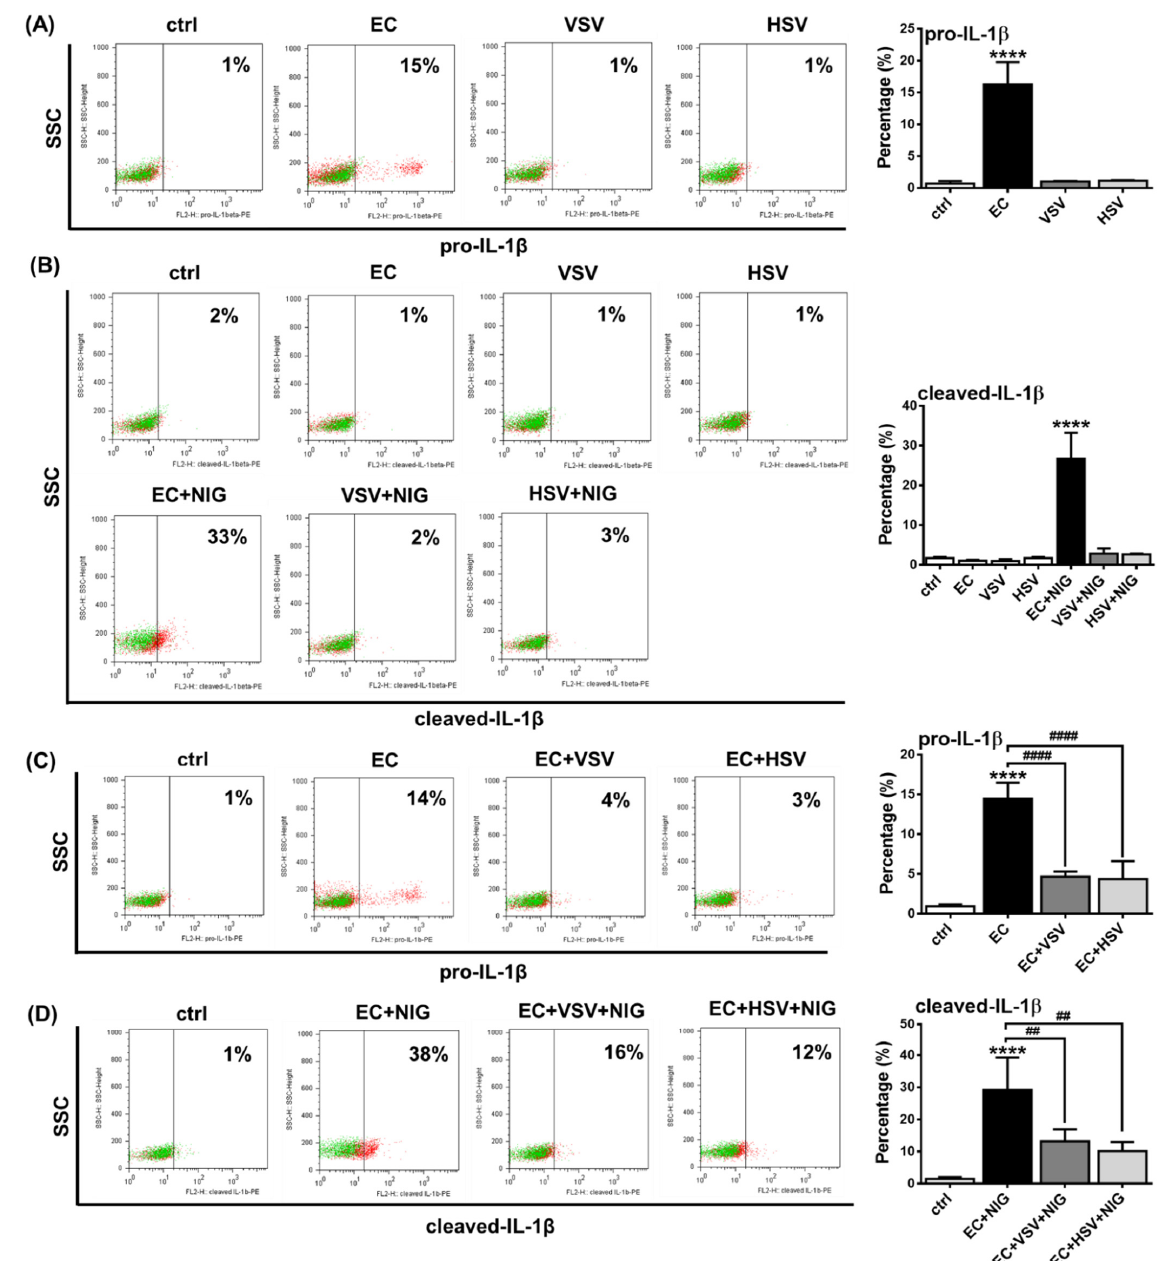
Figure 8. VSV or HSV pretreatment inhibits the IL-1 β production in primary human pDCs. PBMCs were separated from peripheral blood of healthy individuals, then the cells were analyzed by flow cytometry for pDCs. PBMCs were incubated in the presence of E. coli, VSV or HSV at a MOI of 10 ( A ). After priming, cells were incubated in the presence of 20 µ M nigericin for 1 h, where it is indicated ( B ). In parallel experiments cells were pretreated with VSV or HSV (MOI 10) for 3 h and then activated with E. coli (MOI 10) for an additional 3 h ( C ) . To induce the cleavage of IL-1 β , nigericin was added to the cells for an additional 1 h ( D ). The percentage of pro-IL-1 β ( A , C ) and cleaved IL- 1 β ( B , D ) -positive pDCs was measured using intracellular flow cytometry. Representative dot plots are shown in ( A – D ). Green dots indicate isotype controls and red dots show the specific proteins ( A – D ). Data are represented as means ± SD of 4 individual experiments and analyzed using one-way ANOVA followed by Bonferroni’s post-hoc test. **** p < 0.0001 vs. control (ctrl), ## p < 0.01, #### p < 0.0001. VSV: Vesicular Stomatitis Virus , HSV: Herpes Simplex Virus , EC: E. coli , NIG: nigericin, SSC: side